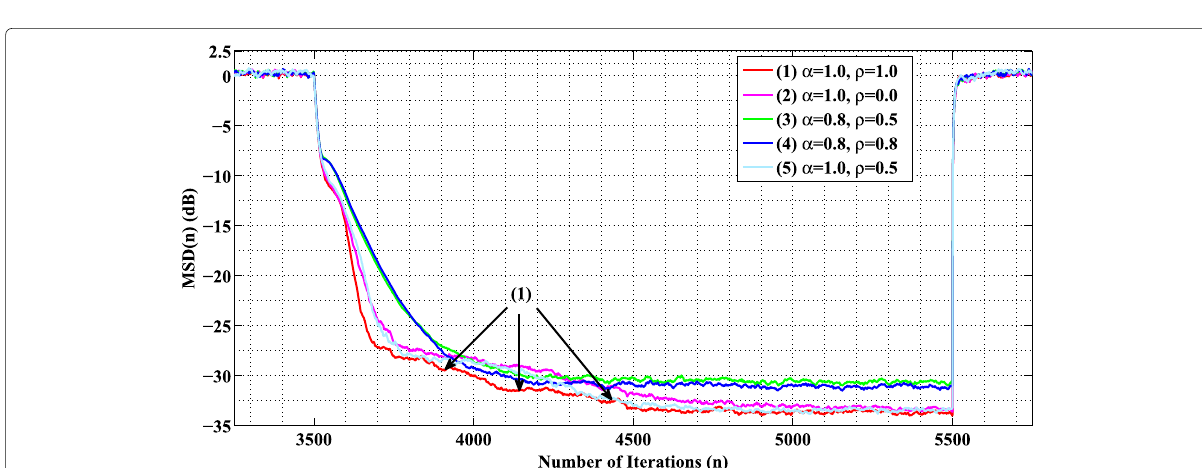
Fig. 20 Effect of using both transfer and momentum terms on the MSD performance of the R-CFLF scheme when input signal is white noise